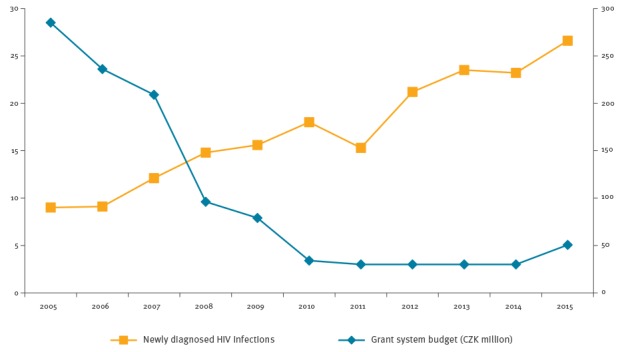
Annual budget of the grant system of the National programme for tackling HIV/AIDS and newly diagnosed HIV infections in the Czech Republic in 2005–2015